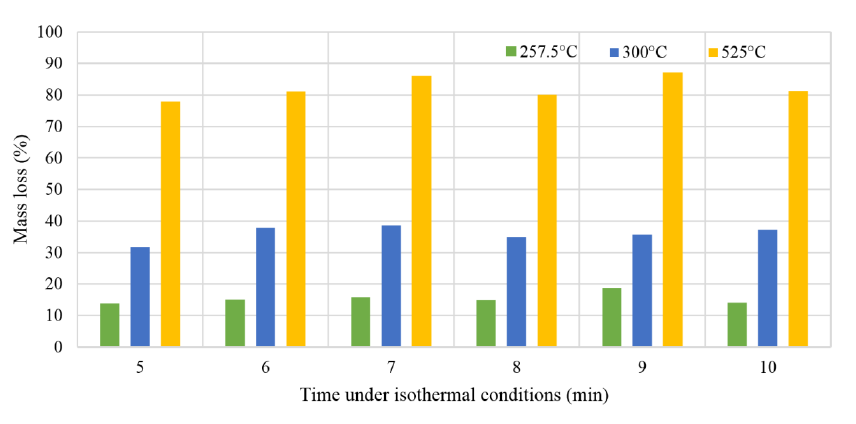
Figure 13. Torrefaction process of Miscanthus: Thermogravimetric analysis results and optimal process conditions for the production of carbonized solid biofuel, carrier for natural fertilizer and activated carbon (Figure 13 heating ratios: ( a ) 5 K/min, ( b ) 10 K/min, and ( c ) 20